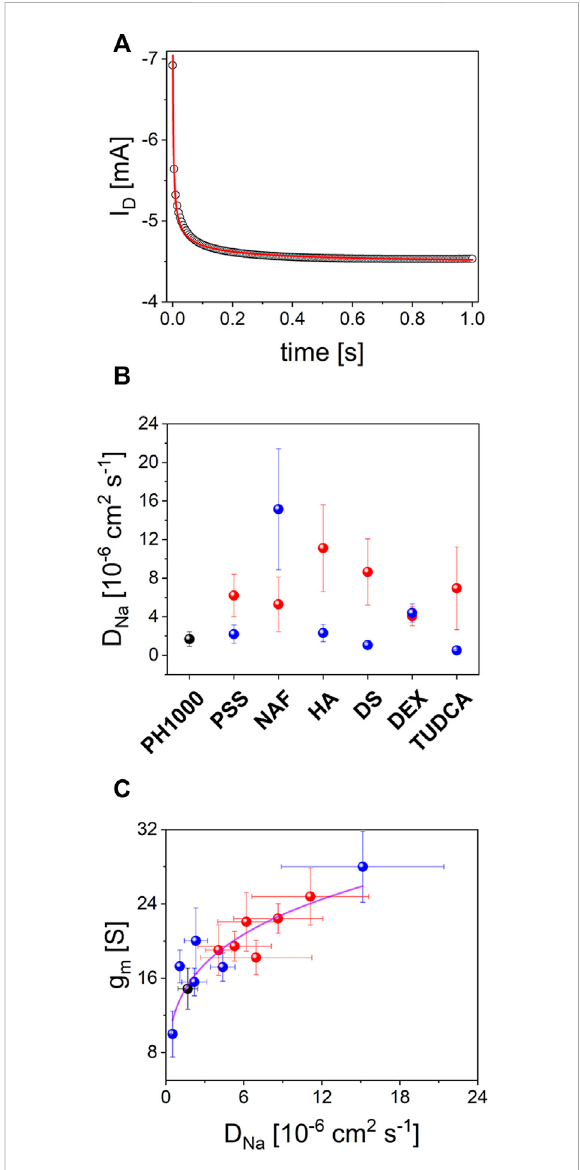
FIGURE 7 OECTs characterization: (A) typical drain current transient decay under a constant gate bias pulse (see experimental section for details), experimental data (black circles) were fi tted according to Eq. 2 (red line); (B) D Na values extracted from drain current transient decay according to Eq. 2 for OECTs based on PH-1000 (black dots) andPEDOT/NAF deposited atQ dep = 25 mC cm − 2 (red dots) or Q dep = 100 mC cm − 2 (blue dots) (mean ± SD from a set of three different devices); (C) plot of g m,max vs . D Na